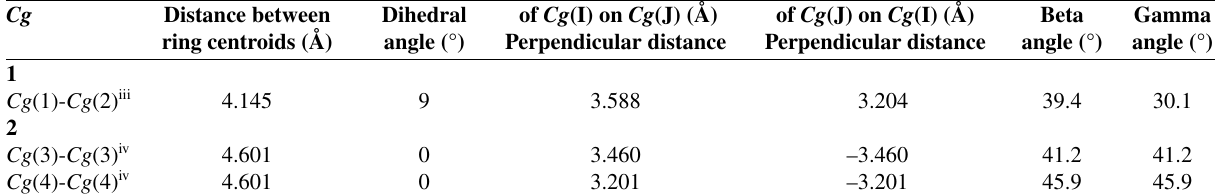
Table 3. Parameters among planes for the compounds Cg Distance between Dihedral of Cg (I) on Cg (J) (Å) of Cg (J) on Cg (I) (Å) Perpendicular